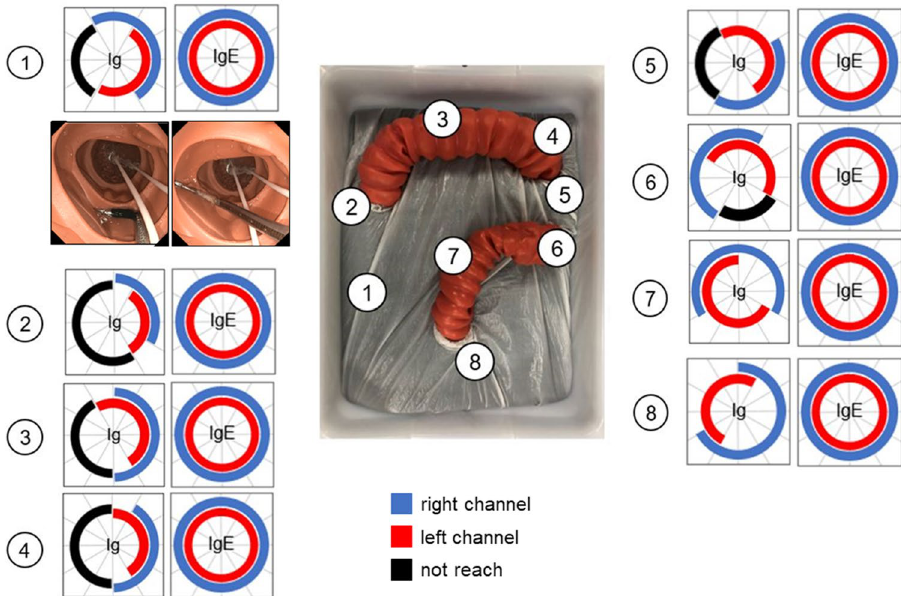
Figure 4. Reach of Ig/IgE. The reach of Ig/IgE was demonstrated at each position (sites 1–8). The range in blue indicates the reach when Ig/ IgE was inserted through the right channel, the range in red indicates the reach when Ig/IgE was inserted through the left channel, and the range in black indicates the area that was inaccessible by either channel. In site 1, a representative endoscopic image shows that IgE was able to reach the area on the left where Ig could not.